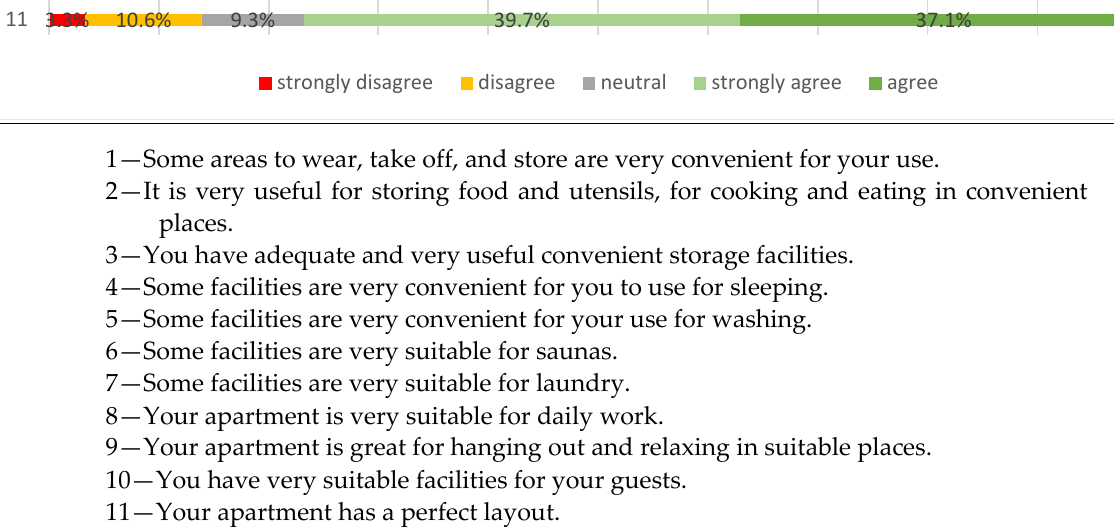
Figure 16. Functional features in the apartment.